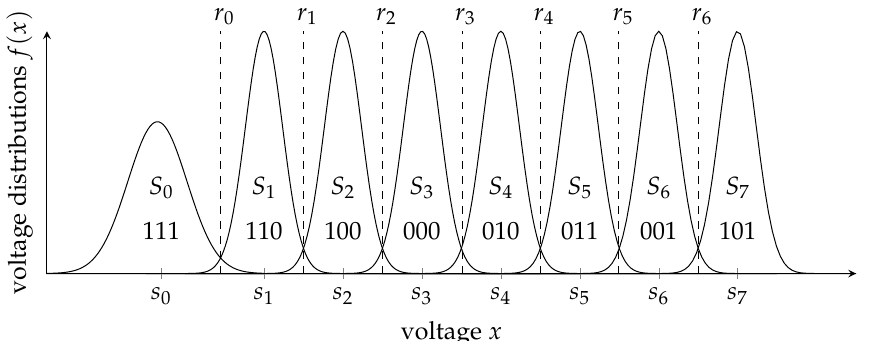
Figure 1. Example of the voltage distribution of a TLC flash memory, with read reference voltages (dashed lines) and bit-labeling with Gray